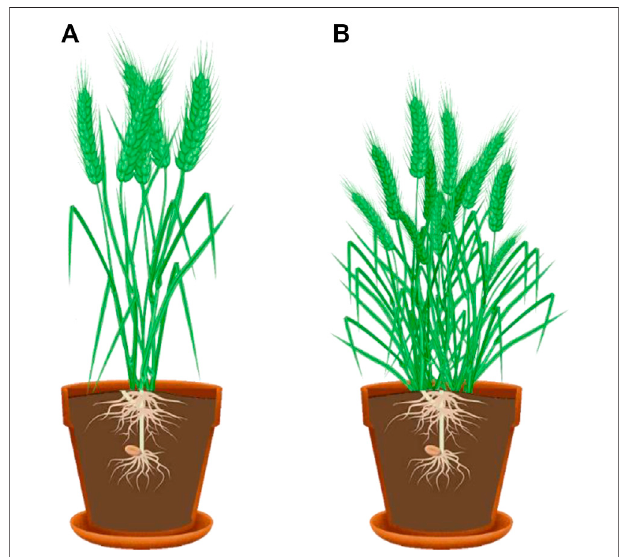
FIGURE 7 | The growth status of wheat in low pressure environment: 50 kPatotalpressure10.4or5.0 kPaoxygenpartialpressure (A) ,and50 kPa total pressure 2.5 kPa oxygen partial pressure (B) (Guo et al.,